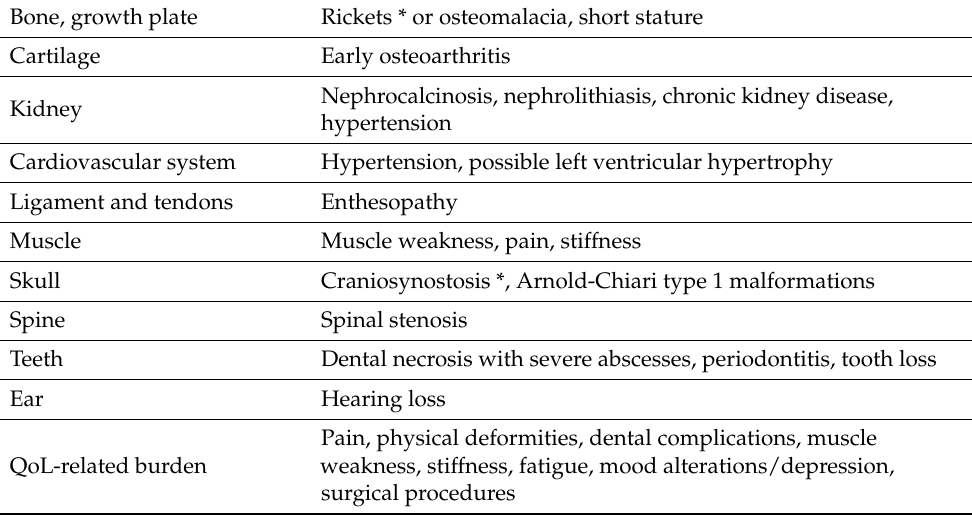
Table 1. Clinical features and disease burden